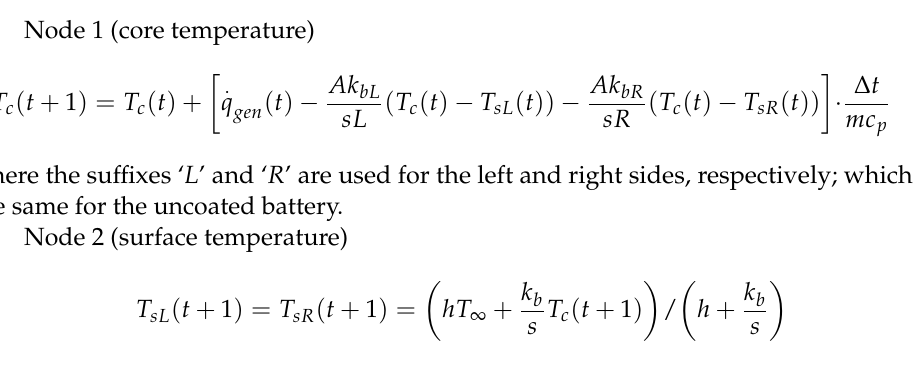
Figure 3. Scheme of the 1D model and air/battery thermal properties. The heat flux directions, the nodes labels, and the symmetry axis are reported.